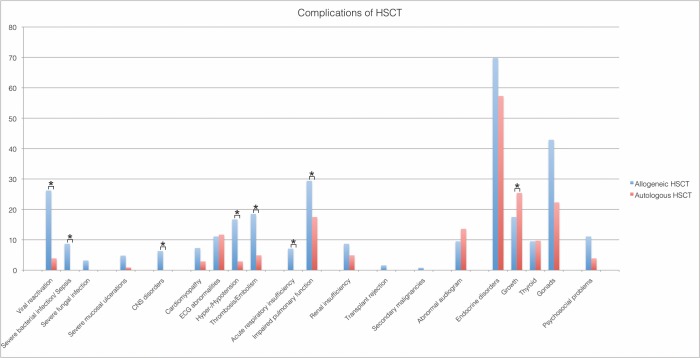
Complications of HSCT.Percentage allocation of specific complications in allogeneic (n = 126; overall complication rate 88.9%) and autologous (n = 103; overall complication rate 56.3%) patients (p < .001). The distribution of specific complications across all patients with complications is displayed as a bar diagram. Statistical significant differences (p ≤ 0.05) for the comparison between allogeneic and autologous HSCT as detected by pair-wise Chi-Square test for viral reactivation, severe bacterial infection, impaired pulmonary function, in endocrine disorders: growth retardation and Fisher’s exact test for acute respiratory insufficiency, thrombosis/embolism, hyper-/hypotension and CNS disorders, are marked with asterisks (*).